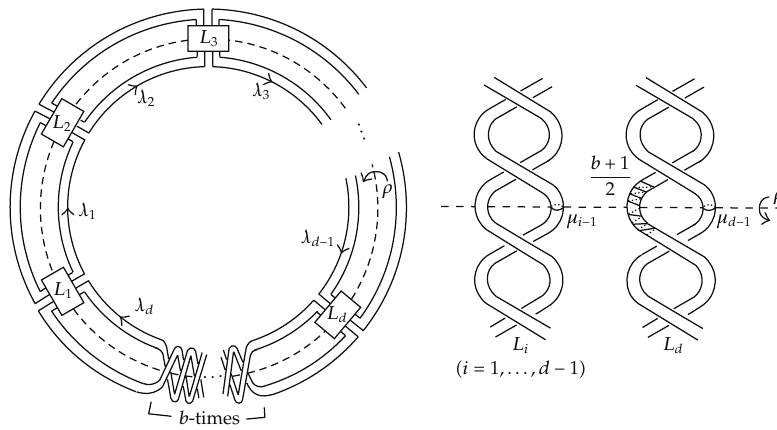
Figure 4: Regular neighborhood of L (cid:4)(cid:4) (cid:3) m,d (cid:4) and strongly